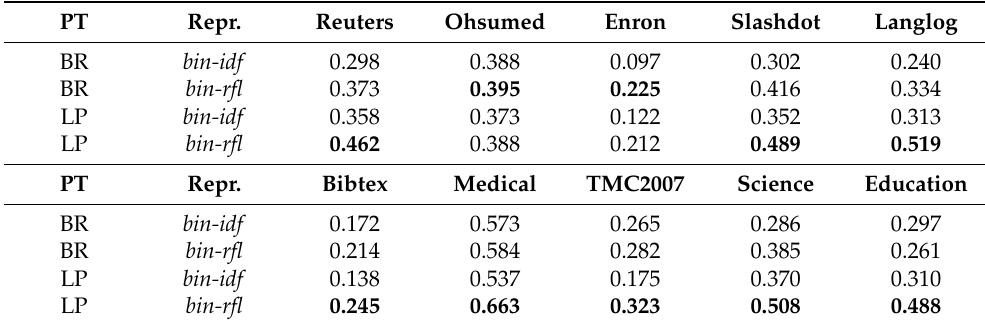
Table 7. Experimental results of different transformations of the problem (PT: BR and LP), and Representations with ANN in terms of Accuracy.